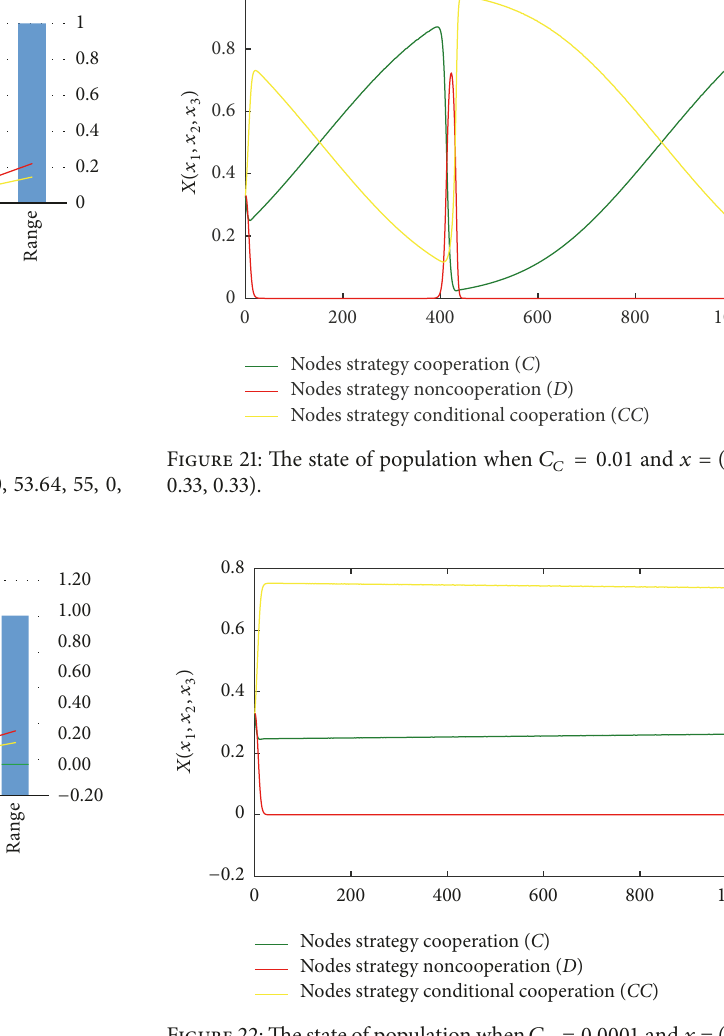
Figure 22: The state of population when 𝐶 𝐶 = 0.0001 and 𝑥 = (0.33, 0.33, 0.33).